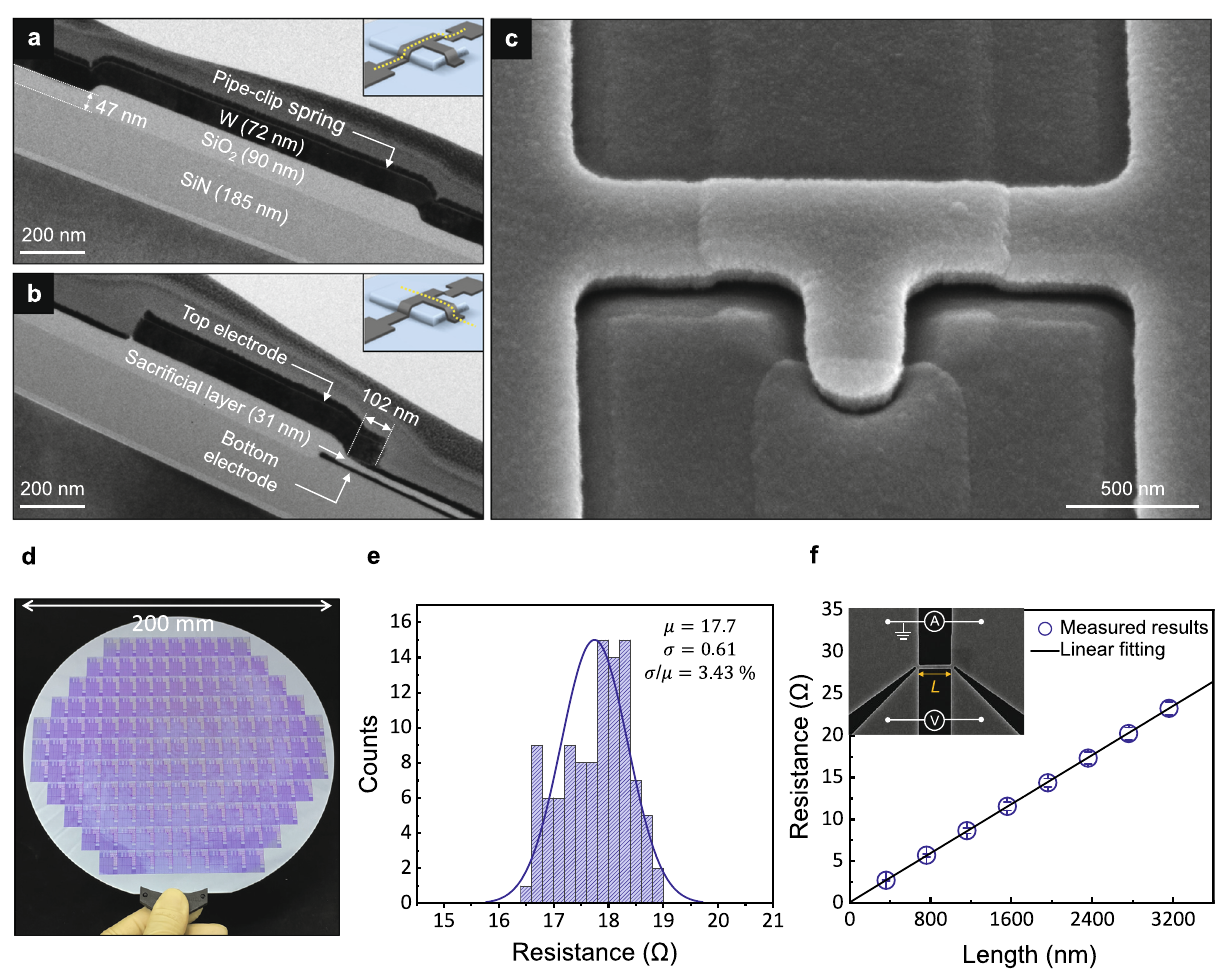
Fig. 2 | CMOS-compatible device fabrication. a , b Cross-sectional TEM images of the pipe-clip spring and bent cantilever of the fabricated NEM-NVM, respectively. Inset fi gures indicate the cross-section plane. c Tilted-view SEM image of the air- suspendedNEM-NVMafterthereleaseprocess. d Opticalphotographofthe8-inch Si wafer fabricated by well-established CMOS manufacturing processes. e Large- areauniformityoftheresistanceofthepipe-clipspringsrepresentedbyhistograms